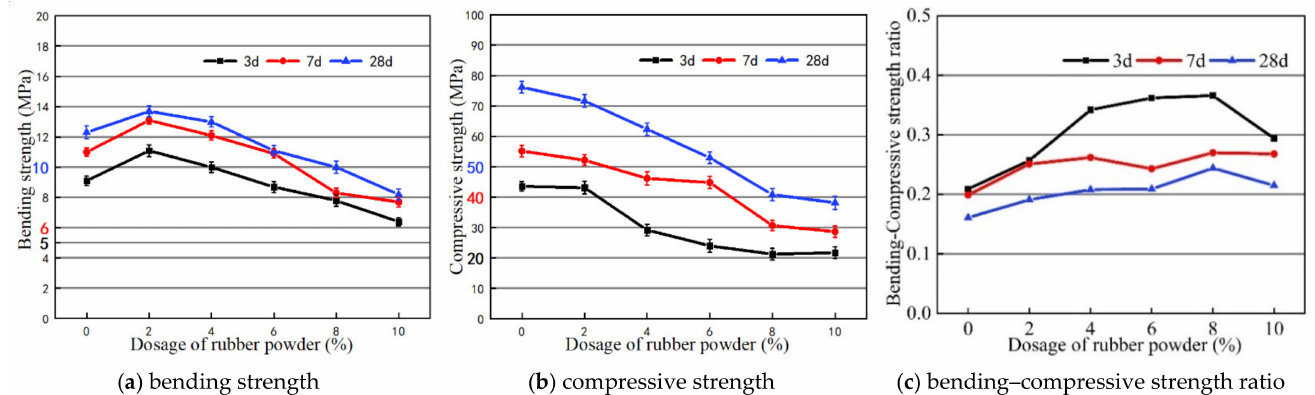
Figure 6. Mechanical strength of PPG with untreated 60 mesh of crumb rubber at different